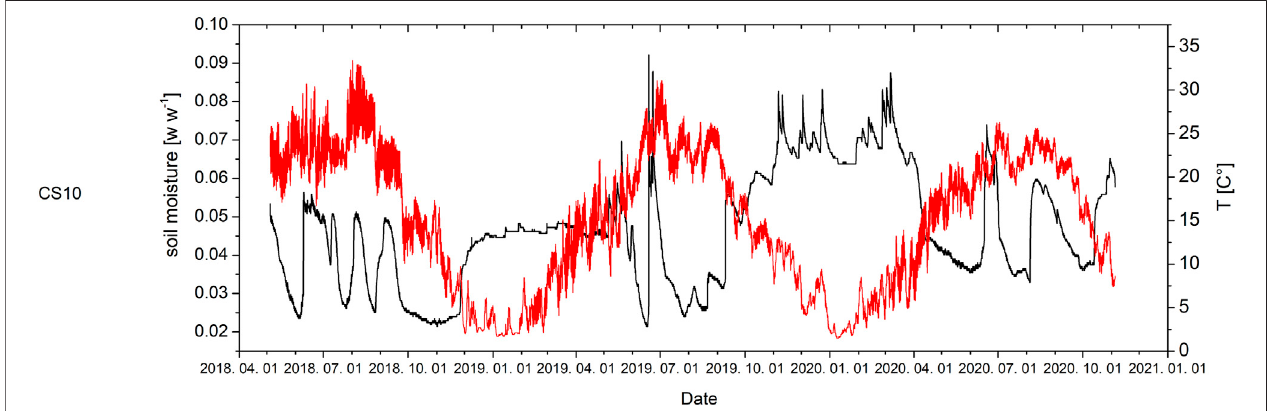
FIGURE 12 | Temperature (red line, right axis in ° C) and soil moisture (black line, left axis in VWC m3/m3) of CS 10 during the three growing seasons (%).